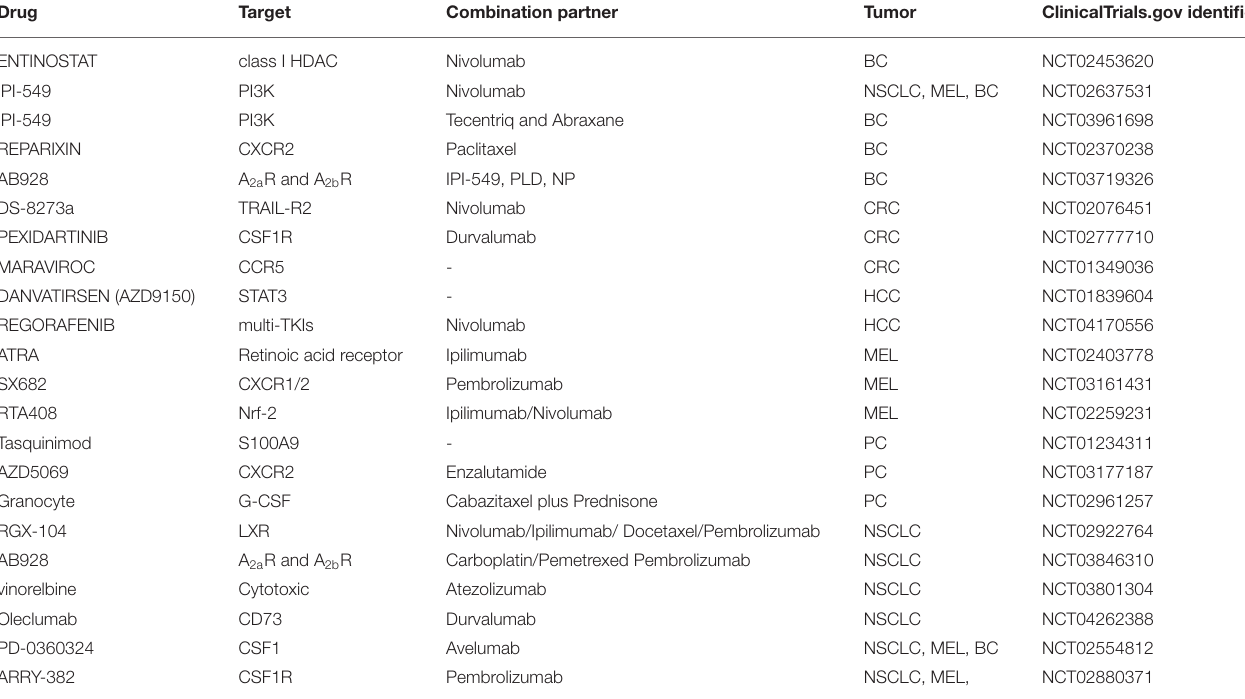
TABLE 2 | Summary of clinical trials targeting MDSCs in cancer